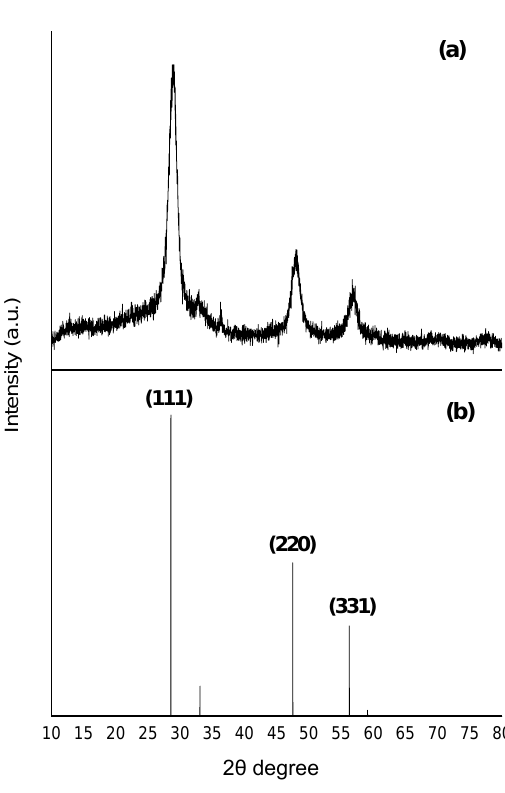
Figure 3. X-ray diffraction (XRD) patterns of: ( a ) ZnS:Mn-Asp NCs; and ( b ) ZnS bulk solid in a cubic zinc-blende phase (JCPDS 05-0566) as an internal reference.